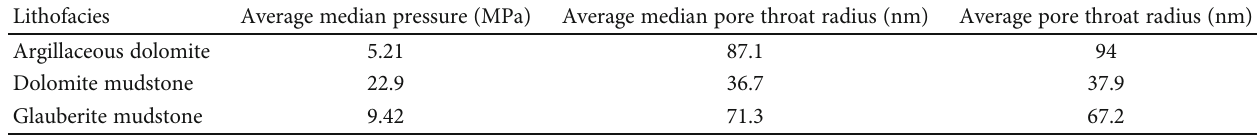
Table 1: Average pore throat radius of di ff erent lithofacies of Qian 3 4 -10 cyclothem in the intersalt dolomite shale reservoir.